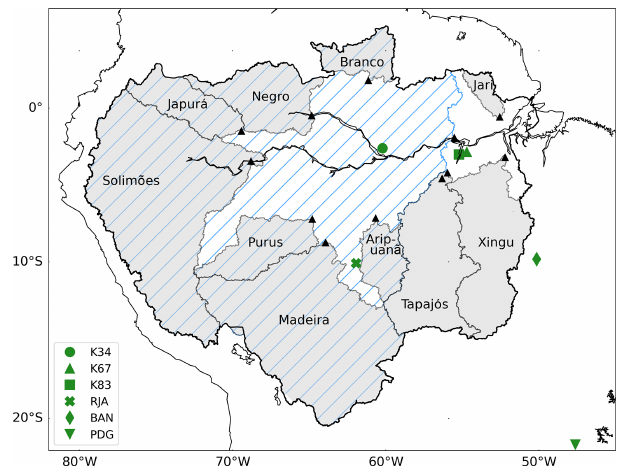
Figure 1. Locations of river catchments and in situ data. Map show- ing the locations of the Amazon sub-basins (grey shaded regions) and the respective river-gauge stations (black triangles) used to es- timate catchment-balance evapotranspiration (ET). Note that two stations in the Tapajós Basin were used (see Sect. 2.1). Blue hatch- ing indicates the area drained by the Óbidos measurement station, which is used to represent “whole” Amazon ET. The locations of the LBA flux towers used in the study are also shown (green markers; see Table S3 for site information). The markers for K67 and K83 have been offset by 0.25 ◦ in longitude and latitude respectively to improve